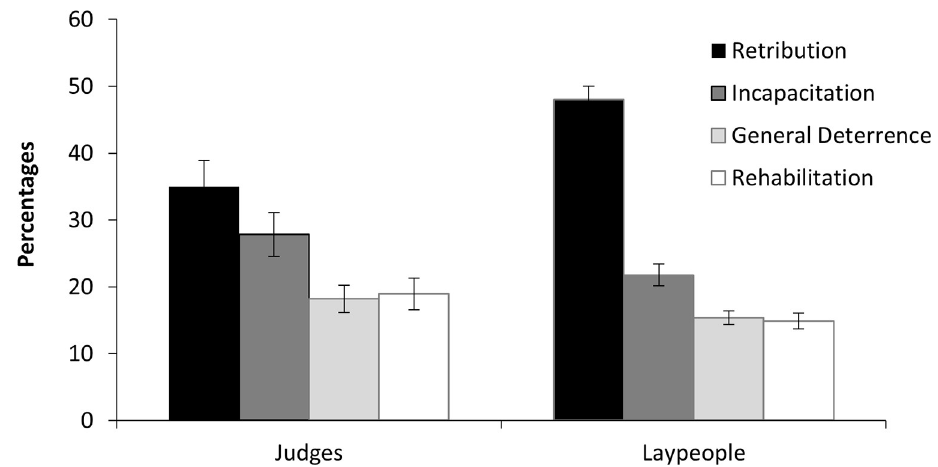
Fig 1. Importance scores and standard error for justification on a ratio-type scale.